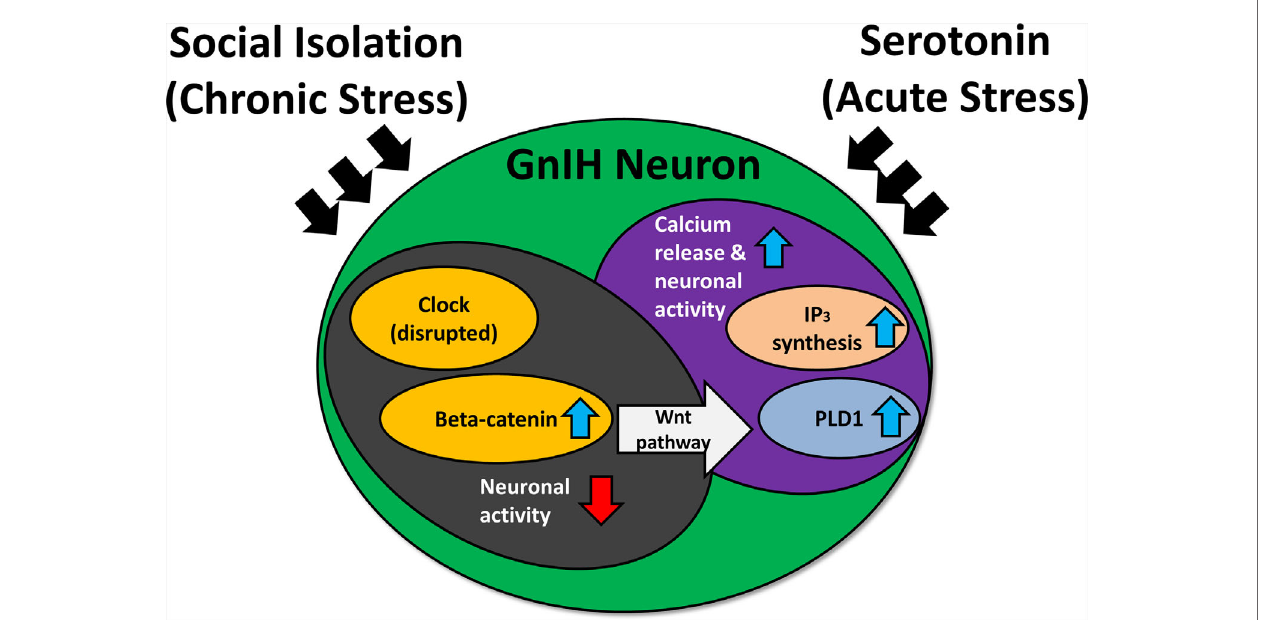
FIGURE 3 | The effect of social isolation and serotonin on CLOCK expression and neuronal activity of gonadotropin-inhibitory hormone (GnIH) neurons. IP 3 , inositol trisphosphate; PLD1, phospholipase D1. Blue arrows indicate an increase, while red arrows indicate a decrease. Chronic stress may disrupt the expression of clock genes, inducing an increase in beta-catenin while lowering neuronal activity. The heightened levels of beta-catenin activate the Wnt pathway, which can upregulate PLD1 levels. This results in increased IP 3 production, triggering a heightened calcium response under acute stress and subsequently elevating neuronal